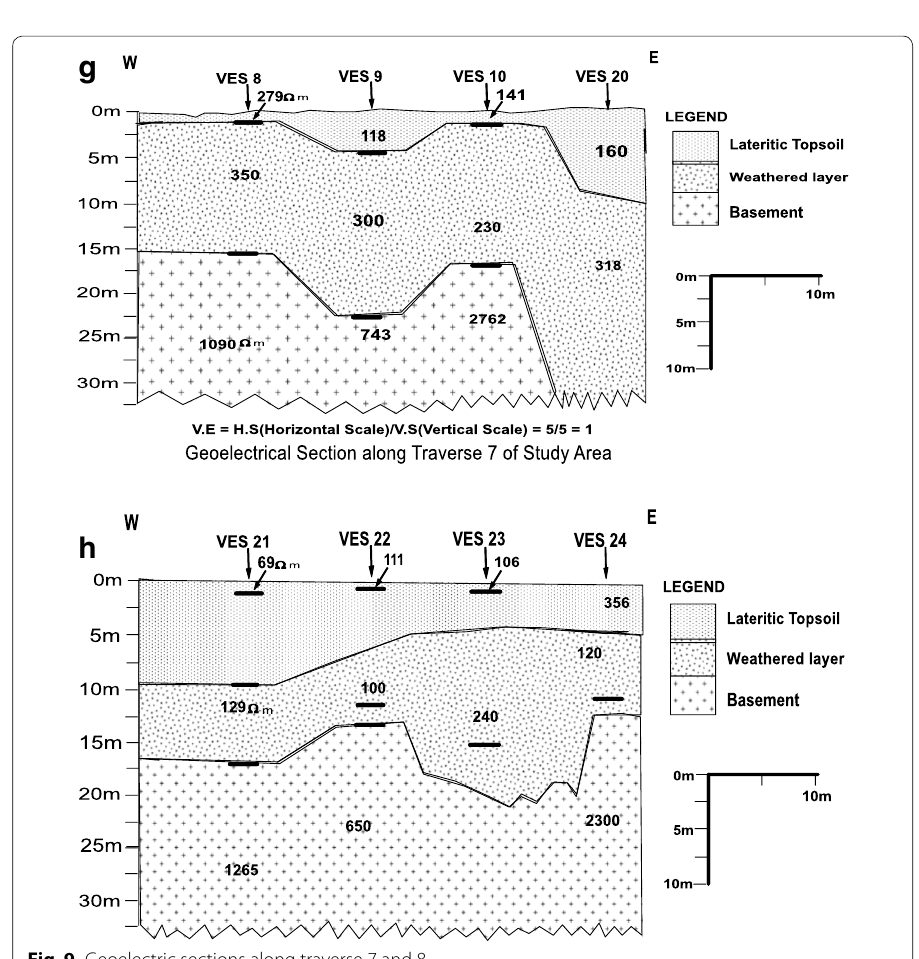
Fig. 9 Geoelectric sections along traverse 7 and